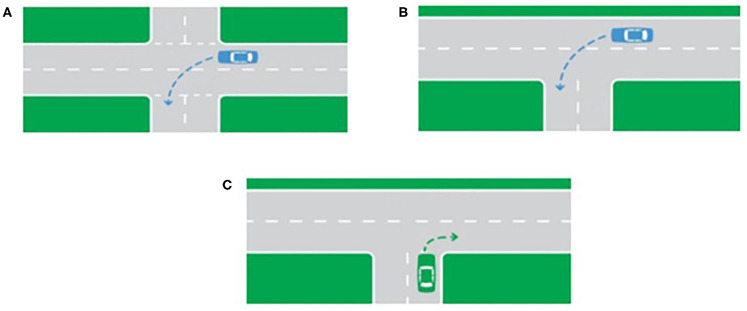
(A) A left turn at a four-way intersection. (B) A left turn at a two-lane T junction. (C) A right turn at a T junction.